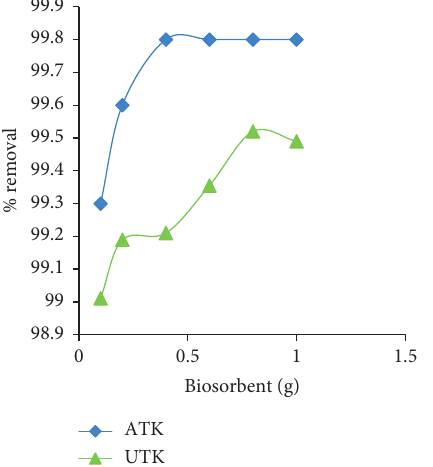
Figure 2: % removal of Cd (II) ions versus biosorbent dose.